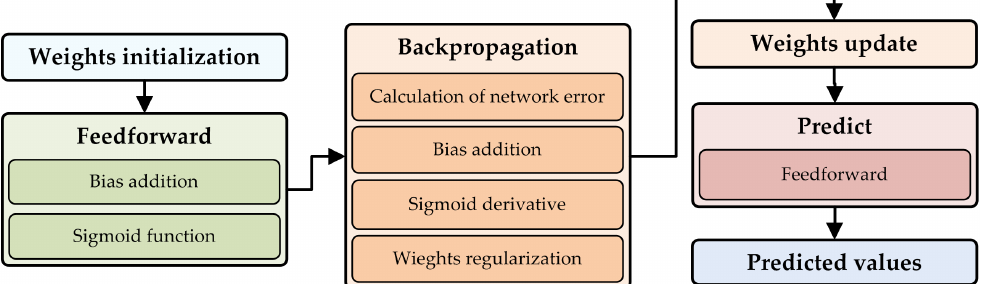
Figure 2. The procedures implemented in the MLP